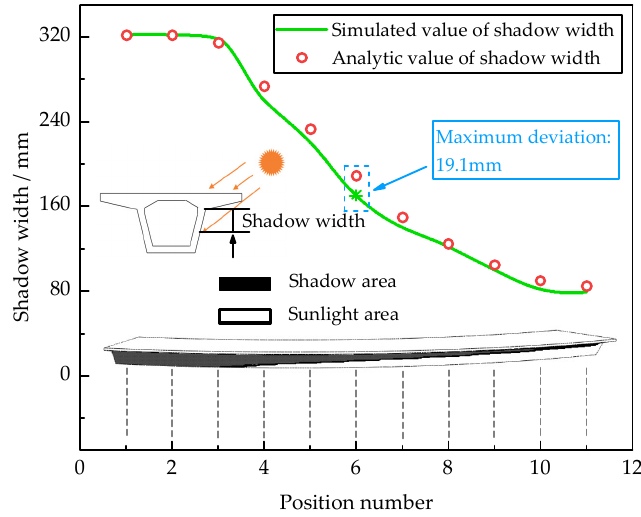
Figure 15. Comparison of Shadow Occlusion Results.